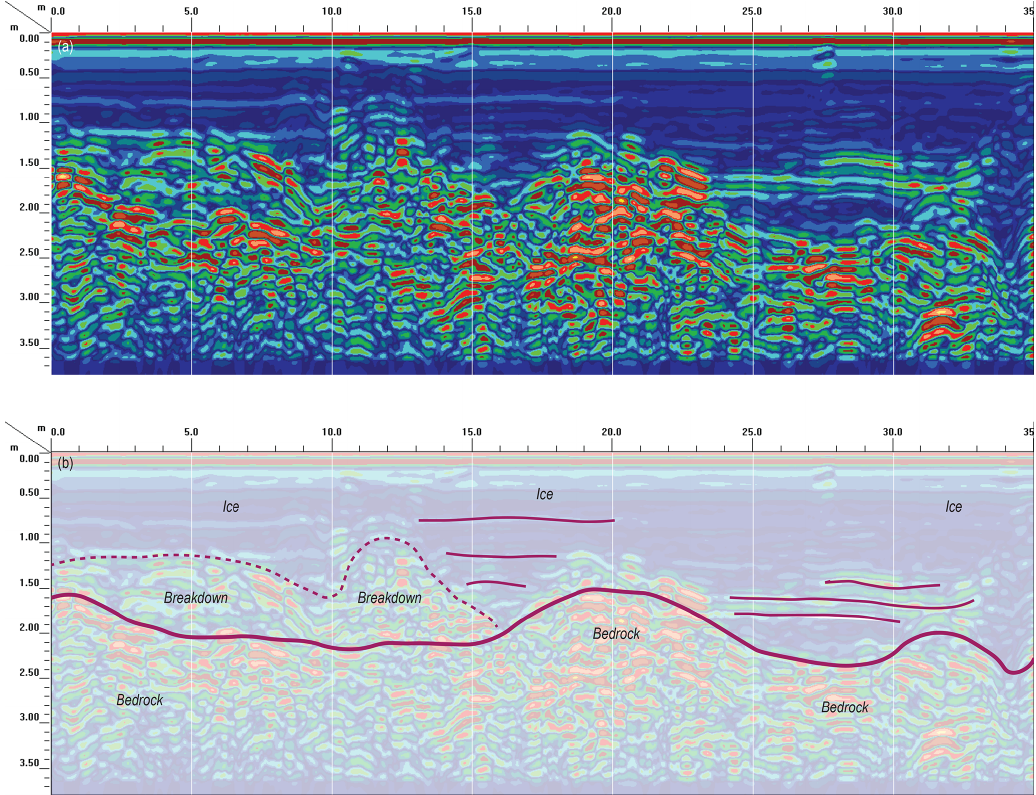
Figure 5. Results of a ground-penetrating-radar (GPR) survey along the Frozen Freeway. (a) Uninterpreted GPR data for half of the full survey length (35m out of 75m), with the back of the cave on the right. Vertical white lines mark measured points every 5m used for scaling the GPR survey. (b) Interpretation of the GPR survey shown in (a) . The bedrock surface is represented by an irregular but laterally continuous contact. More isolated and discontinuous zones of high-amplitude reflectors above this contactor interpreted as piles of breakdown. Ice beneath the Skating Rink, between 20 and 35m along the transect, reaches a maximum thickness of nearly 2.5m. Ice along the Frozen Freeway, between 0 and 20m, has a maximum thickness of ∼ 2m. Horizontal lines within the ice are interpreted as stratigraphic